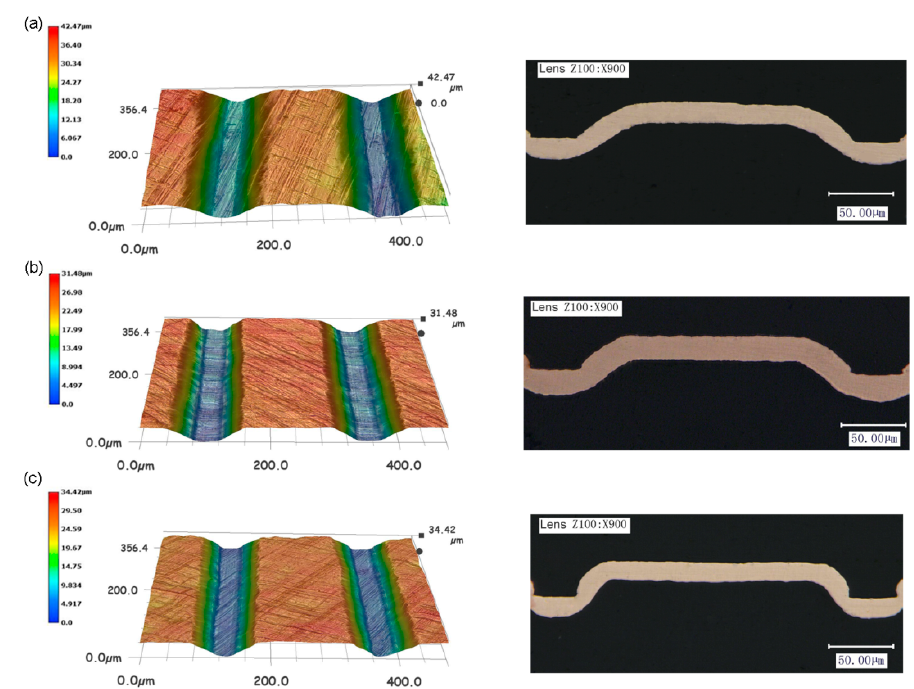
Figure 12. The 3 ‐ D morphologies and cross ‐ section morphologies of the microchannel (channel 5) of the formed parts with the thickness of 20 μ m under different laser energy parameters: ( a ) under the laser energy of 565 mJ, ( b ) under the laser energy of 1200 mJ, and ( c ) under the laser energy of 1800 mJ.